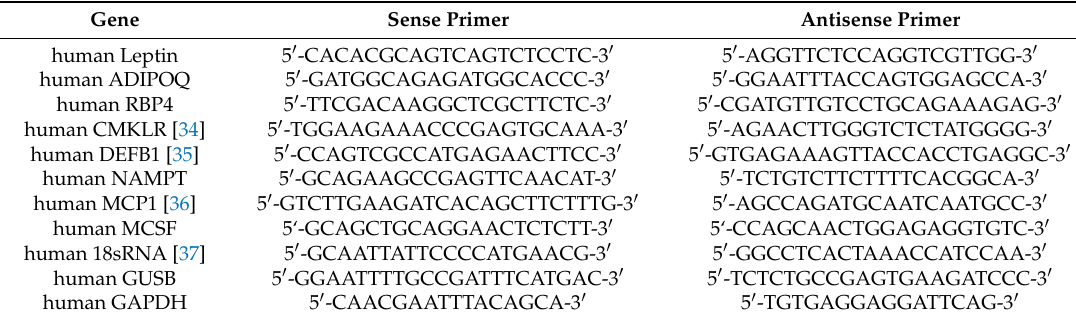
Table 1. Primer pairs used for mRNA